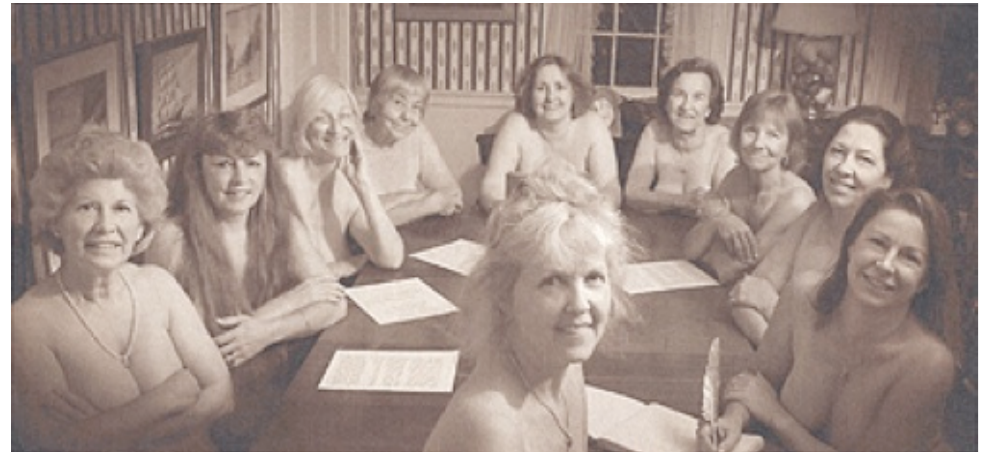
Fig. 1. Dorcas Dishes, fund-raising calendar/cookbook, 2005-6. (Available